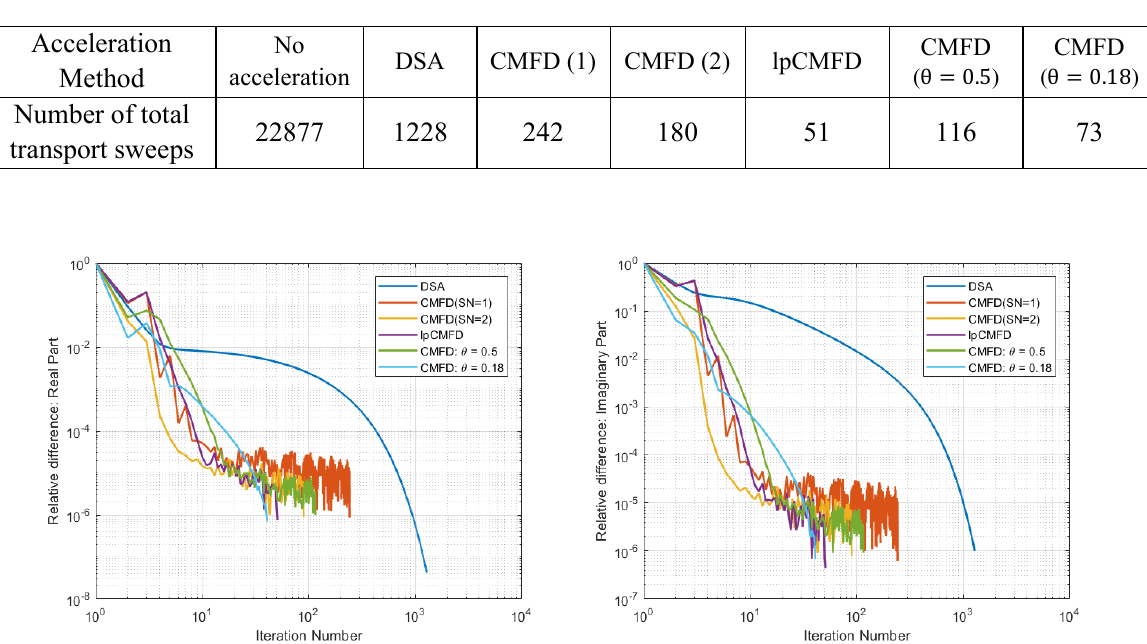
Table II . C3 problem – Acceleration of the dynamic solver with CMFD and DSA methods